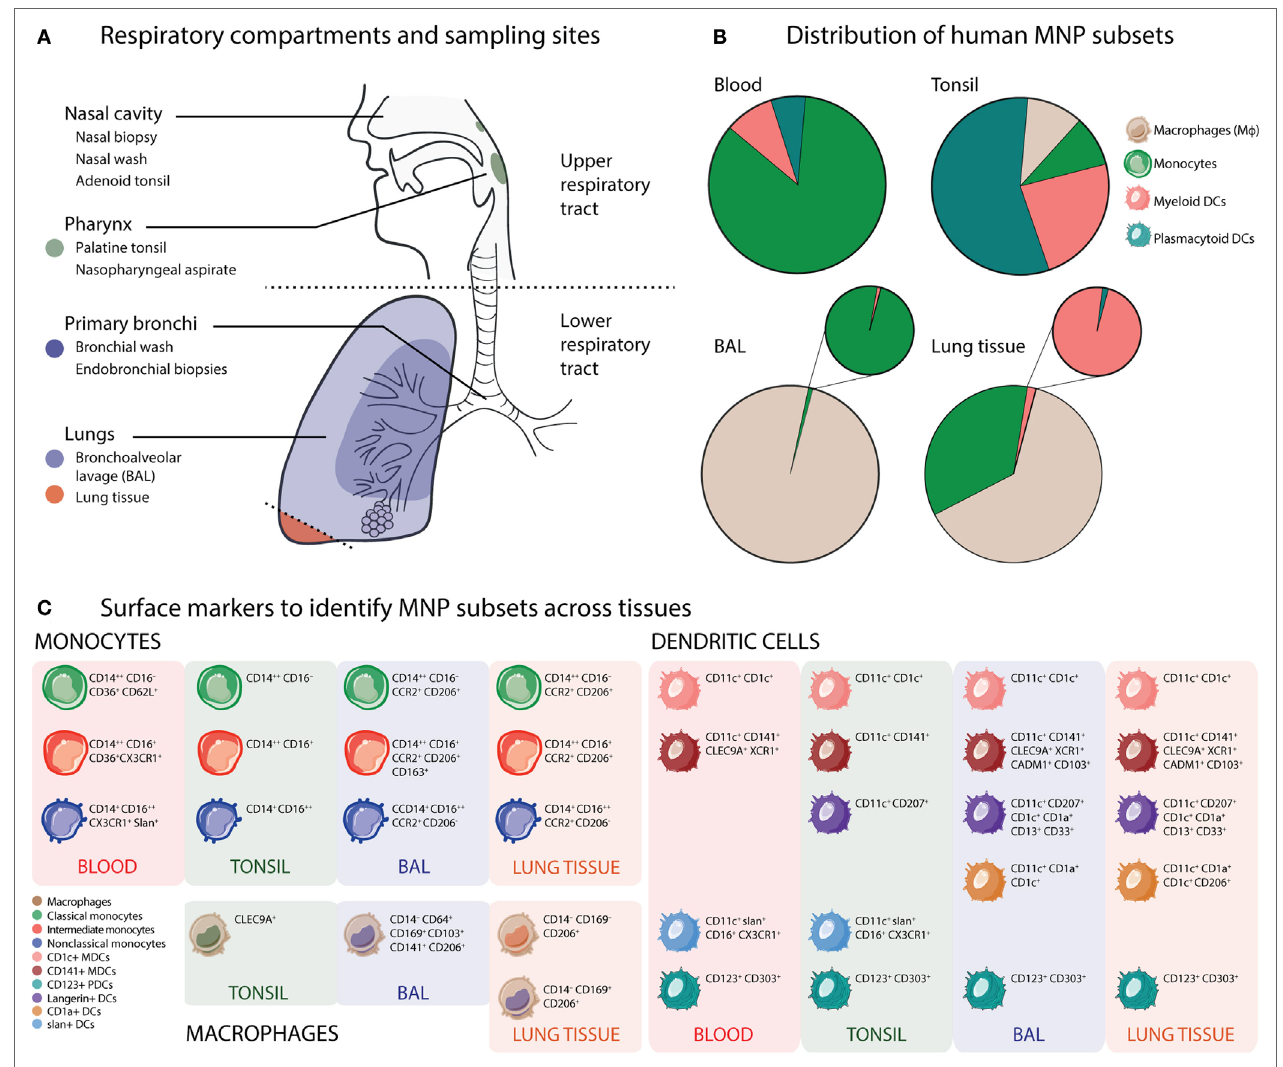
FigURe 1 | Mononuclear phagocyte (MNP) phenotype and distribution vary across human respiratory compartments. (A) Respiratory compartments and sampling sites. In the human upper respiratory tract, the initial site of influenza A virus infection, immune cells including macrophage (M ϕ ), monocyte, and dendritic cell (DC) subsets from the nasal cavity and sinuses can be collected with nasal biopsies or nasal wash sampling. Along with pharyngeal palatine tonsils (and tubal and lingual tonsils), the adenoids form the Waldeyer’s ring, an anatomical structure comprising a ring of lymphoid tissue guarding the pharynx. In the lower respiratory tract, bronchoscopy allows sampling of discrete regions of the airways and lungs. Bronchial washes can be used to sample the cells lining the bronchi and bronchioles. Endobronchial biopsies can also be obtained from the mucosal tissue of the bronchial walls. Bronchoalveolar lavages (BALs) sample the most distal airways and alveolar sacs. Finally, lung resection samples allow sampling of lung parenchyma and tissue-resident immune cells. (B) Distribution of human MNP subsets. Pie charts illustrate broadly pooled data from 21 published studies on human MNP subset distribution in blood, tonsils, BAL, and lung tissue to demonstrate the differential distribution of MNPs across anatomical compartments reported from many research groups (51, 52, 57–61, 63–76). As different studies utilize different strategies to specifically define MNPs, the pie charts show groups of cells typically including several subsets of cells: M ϕ s (beige), monocytes (green), myeloid DCs (MDCs) (coral), and plasmacytoid DCs (PDCs) (teal). (C) Surface markers to identify MNP subsets across human tissues. The various MNP subsets across tissues can be identified using flow cytometry from HLA-DR + leukocytes that do not express lineage (T cells, B cells, NK cells, and granulocytes) markers. Apart from CD123 + PDCs, the MNP subsets express different levels of the myeloid marker CD11c. M ϕ s have been studied in detail in both BAL and lung tissue, where CD169 expression distinguished alveolar from interstitial M ϕ s. Monocyte subsets can be identified from most tissues based on relative expression of CD14 and CD16, as first defined in blood. The major MDC subsets are defined by expression of CD1c or CD141. The extended MDC subsets are now distinguished by expression of CD207 (langerin), CD1a, or slan (51, 52, 57–61, 63–76).